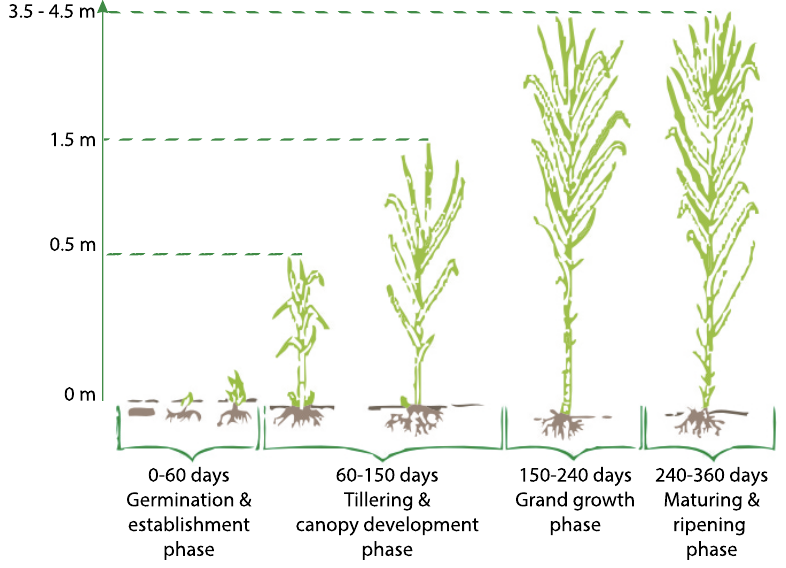
Figure 1. Phenological phases of sugarcane and their corresponding time frames, as well as indicative heights and plant geometries. Adapted and modified from NaanDanJain